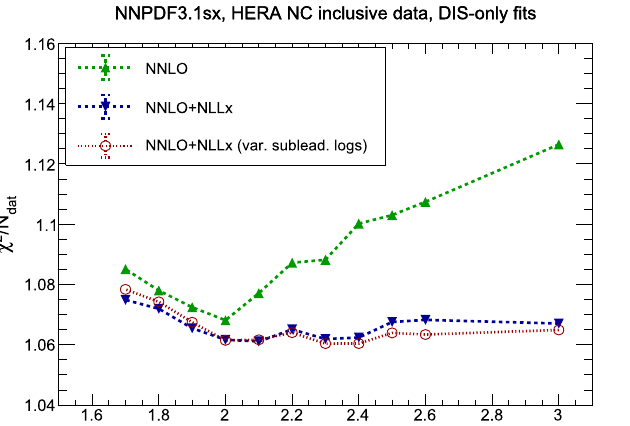
the relative difference between the NNLO+NLL x DIS-only fit and the NNLO+NLL x DIS-only fit performed with a variation of subleading logarithms. Note the different color code with respect to Fig.